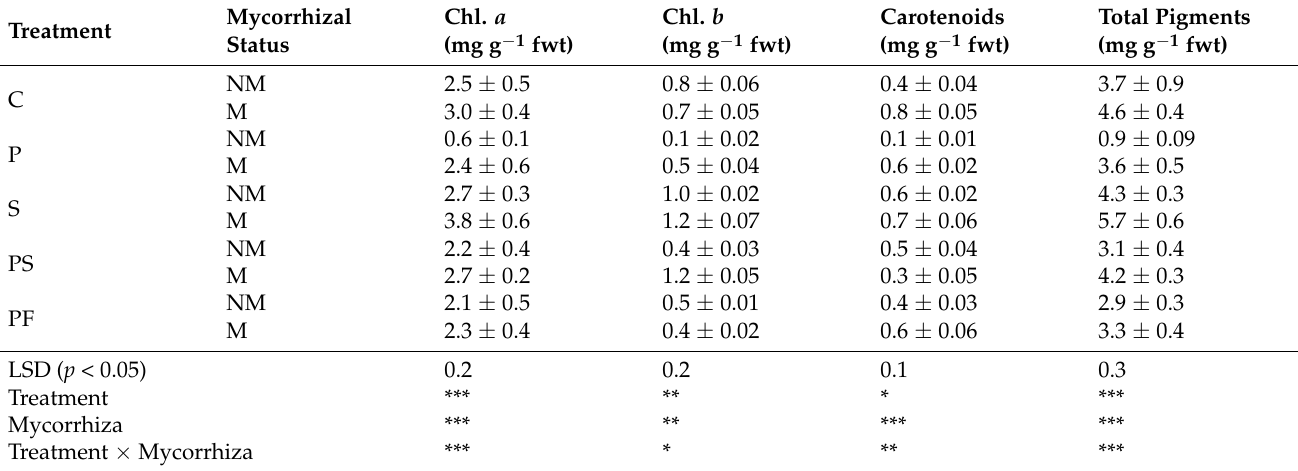
Table 6. Effects of application of S. viridosporus HH1 and/or colonization with R. irregularis on total photosynthetic pigments (40 days post planting) in leaves of pea plants (cv. Master-B) infected